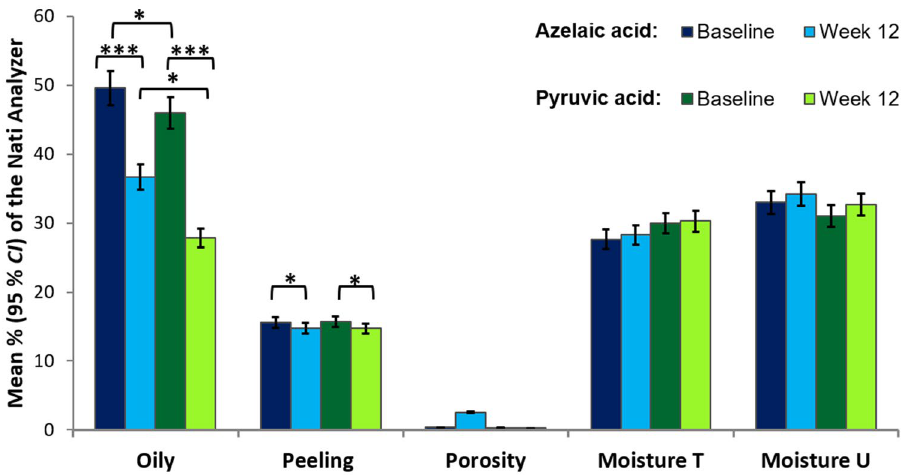
Figure 2. Mean percentages of the Nati Analyzer for oiliness, peeling, porosity, moisture T and moisture U at baseline and 12 weeks after treatment with azelaic or pyruvic acid peels. The error bars are 95% CI . * p < .05; ** p < .01; *** p <